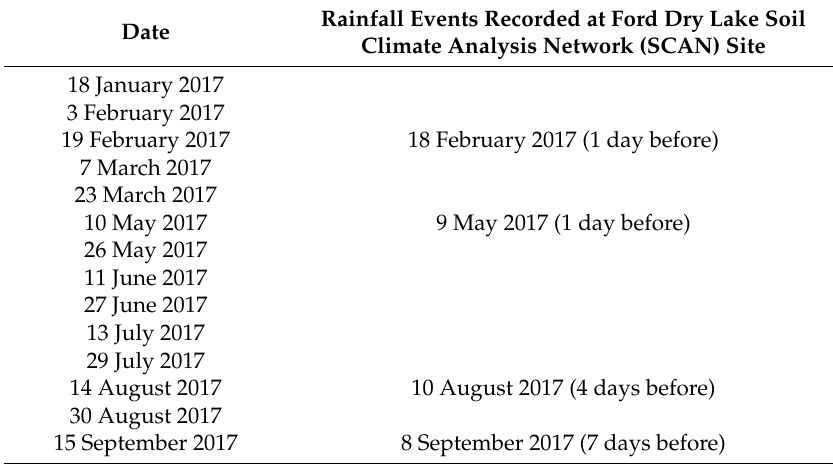
Table 1. Dates in 2017 for which Landsat scenes could be acquired. All days were verified to have minimal cloud cover over the ground temperature measurement